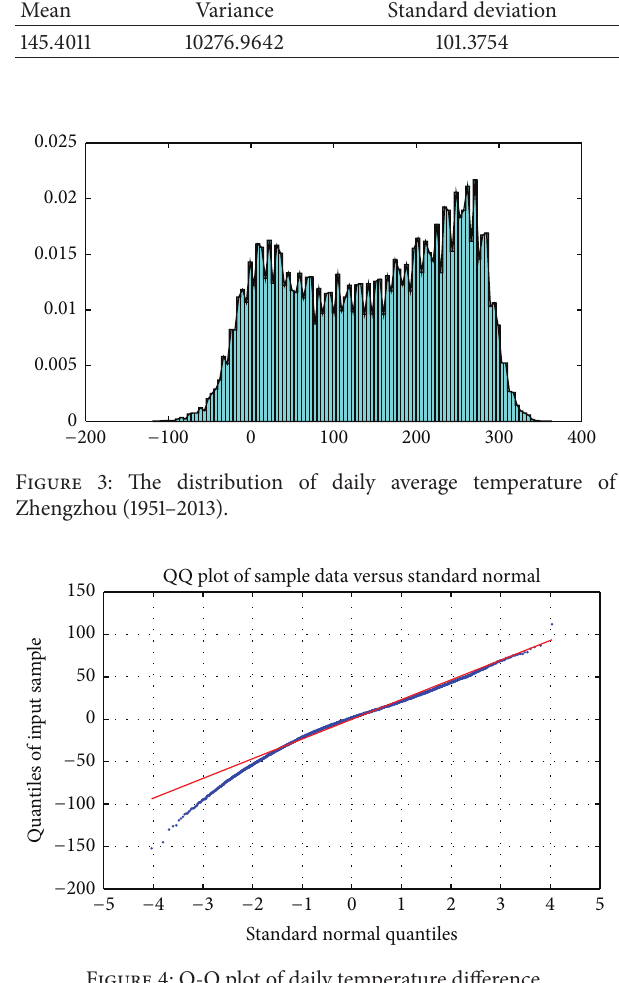
Figure 4: Q-Q plot of daily temperature